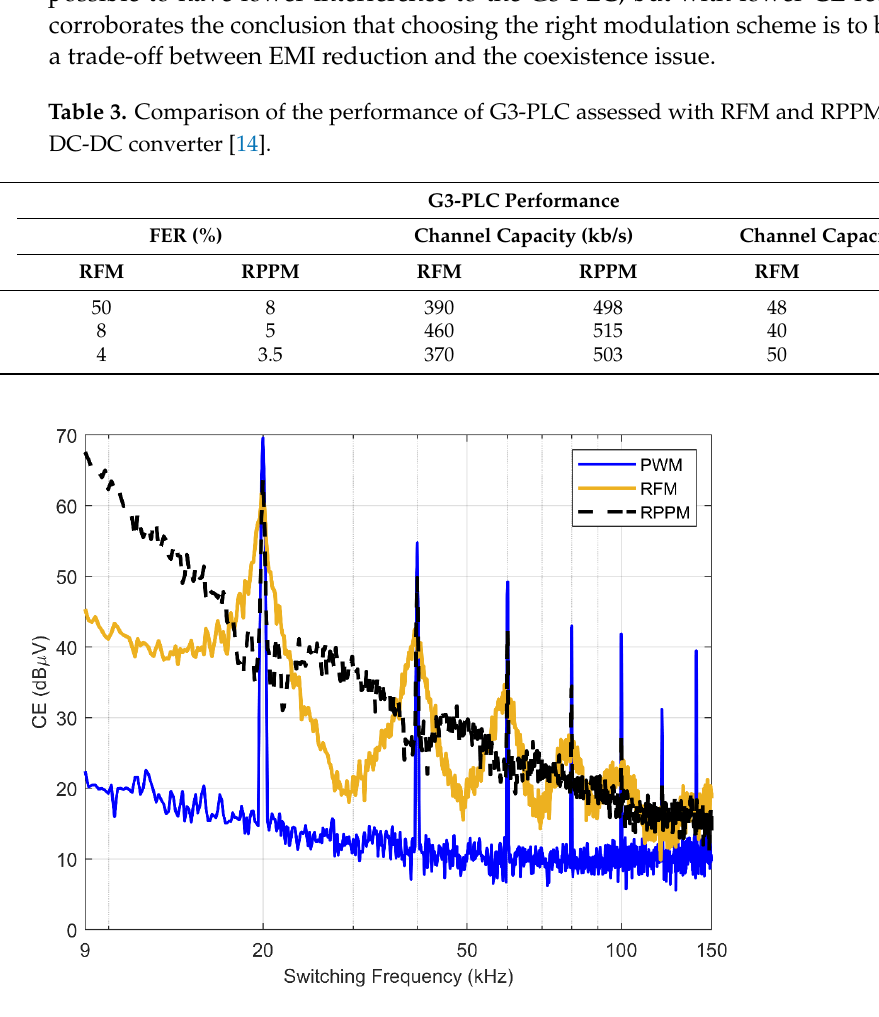
Figure 8. Channel Capacity of the G3 ‐ PLC with different switching frequencies applied to the RPPM modulated DC ‐ DC converter.